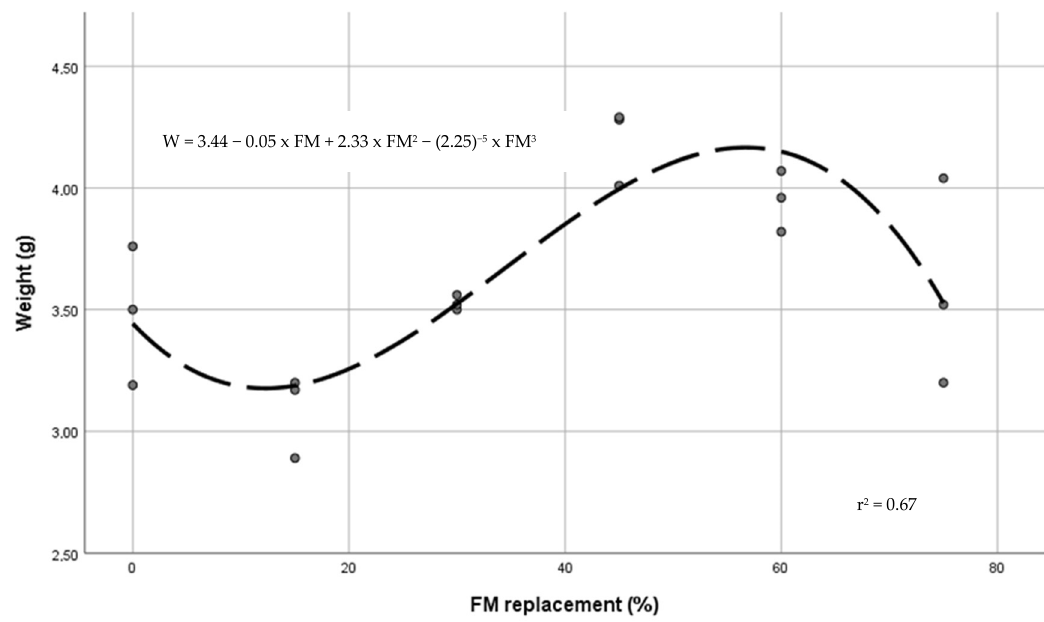
Figure 2. Regression curve between dietary BSFLM and juvenile tench weight (W).